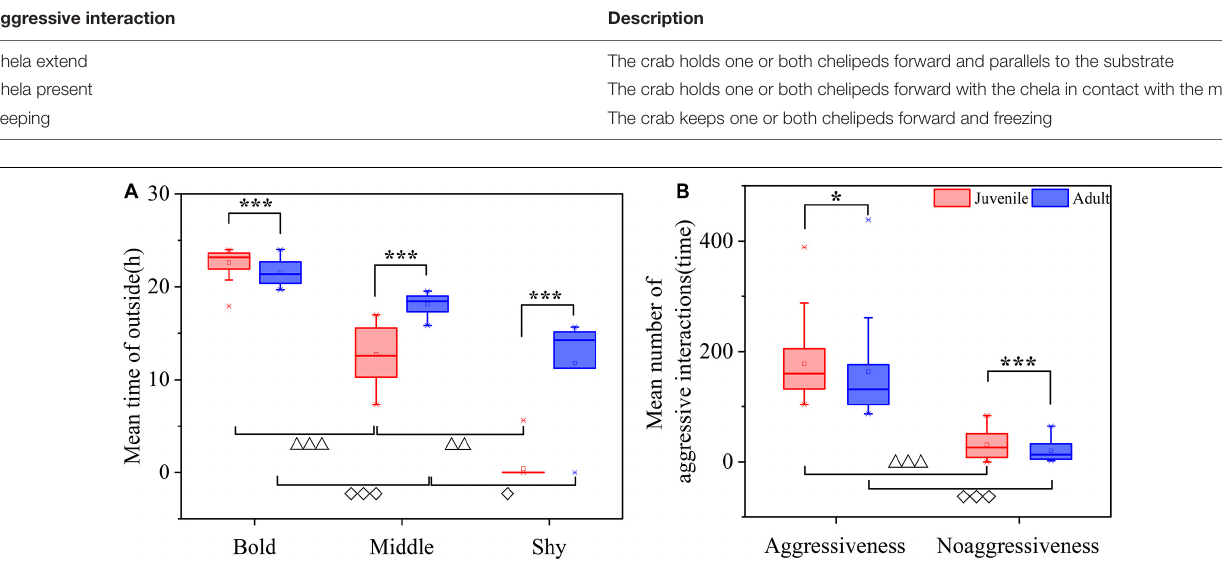
TABLE 1 | Aggressive interaction description.